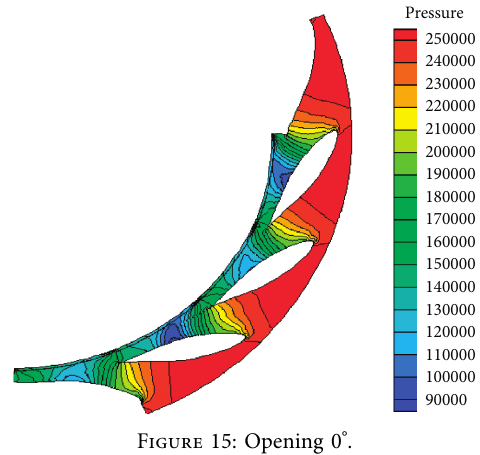
Figure 15: Opening 0 ° .